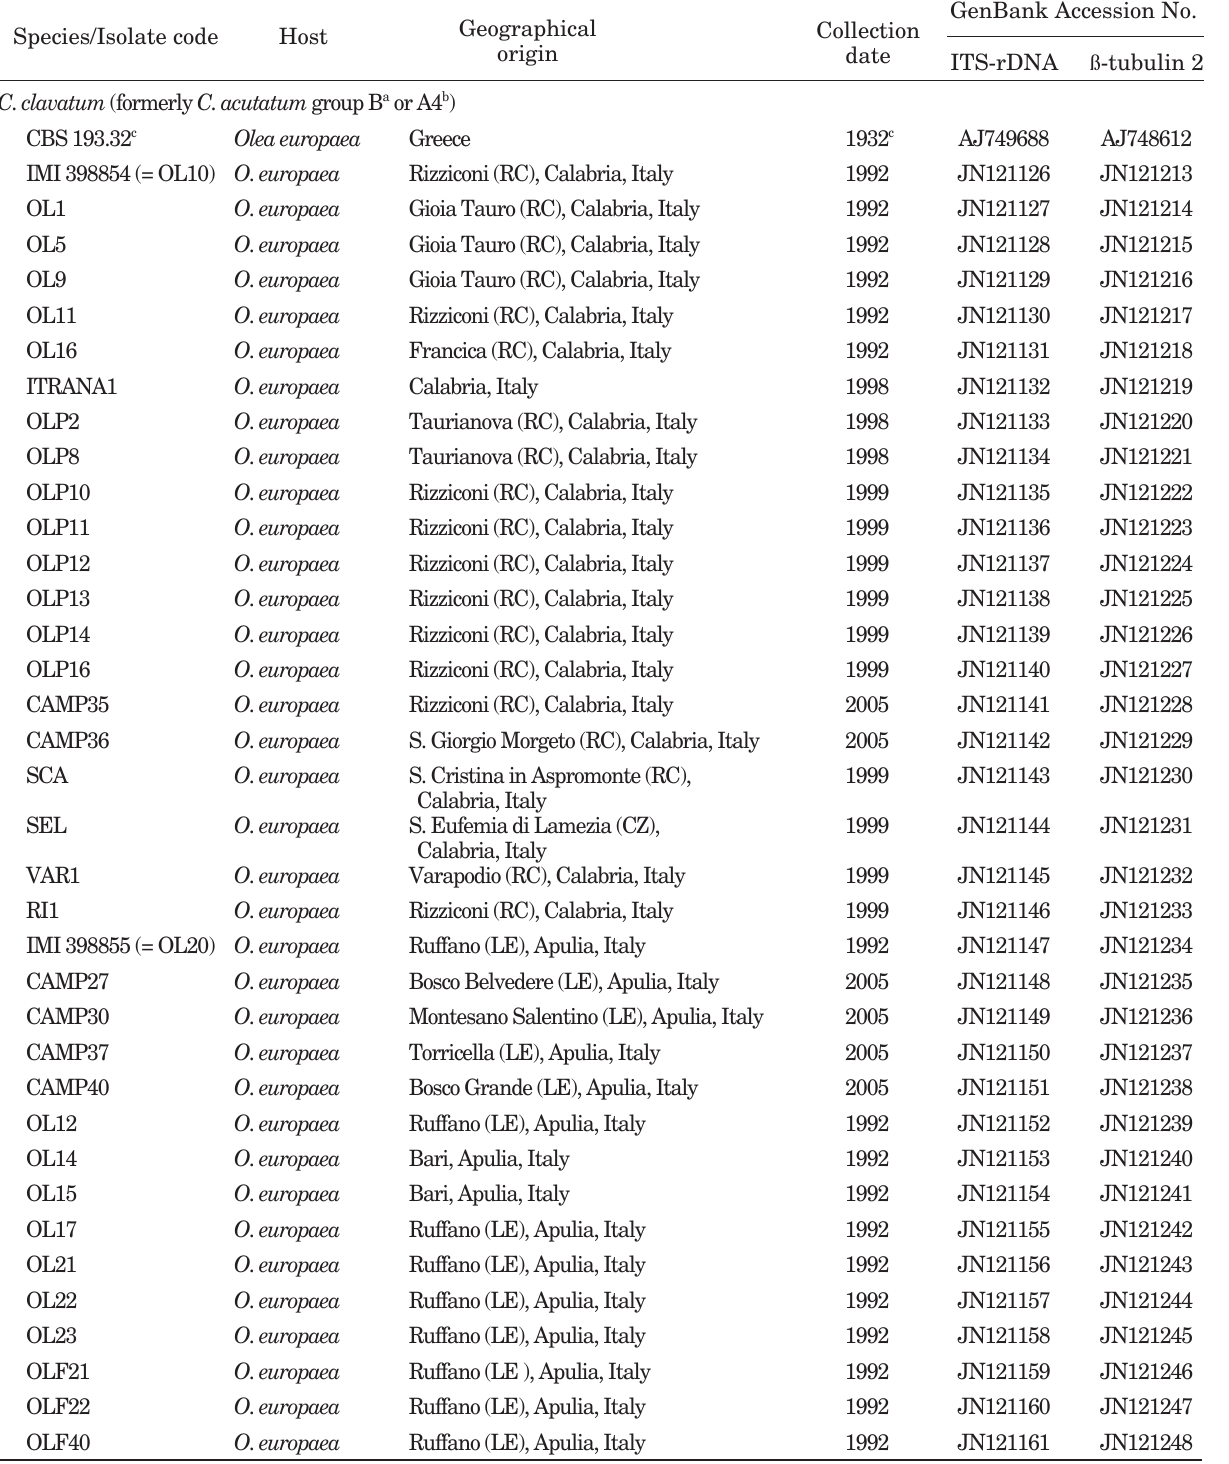
Table 1. Isolates of Colletotrichum spp. examined in this